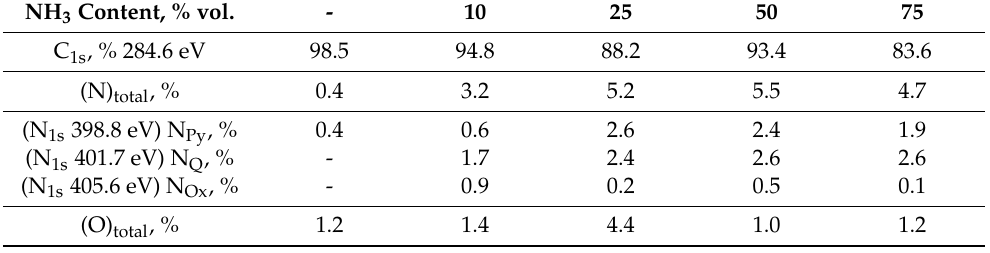
Table 2. Percentage of elements in N-CNT at 650 °C with different ammonia content in initial mixture. NH 3 Content, % vol.